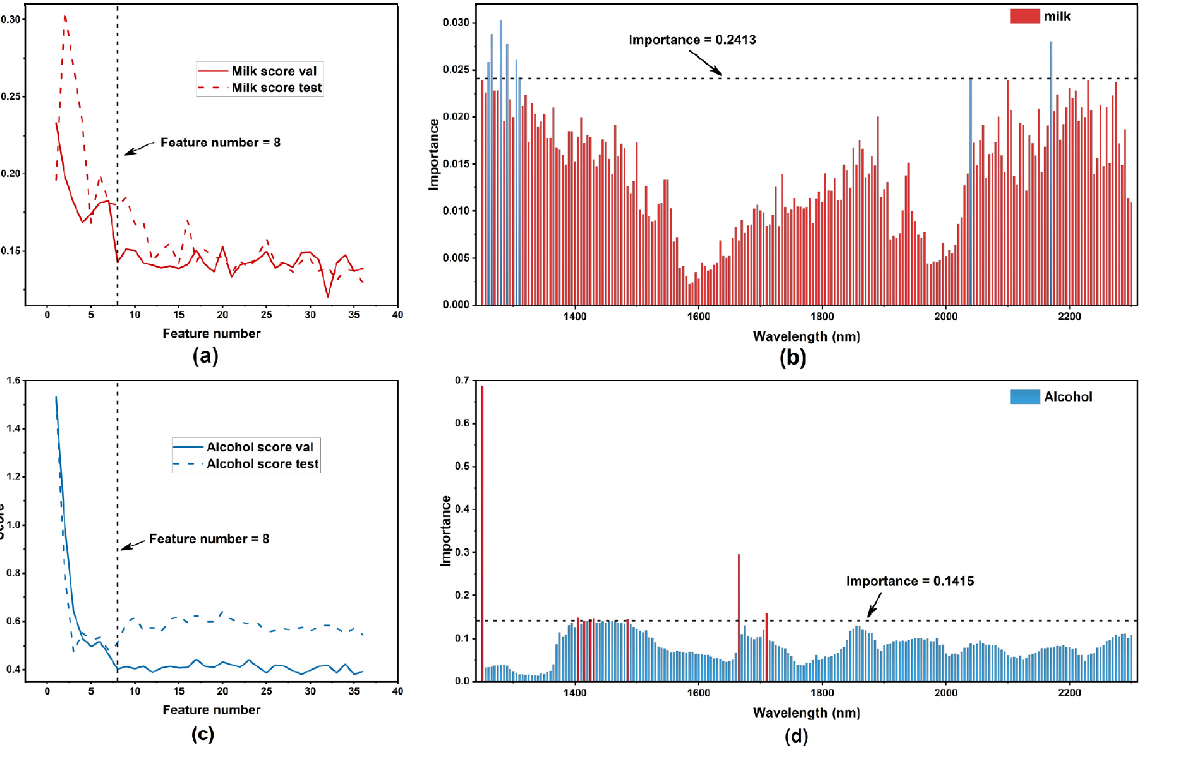
Table 6. Results of feature wavelength selection.